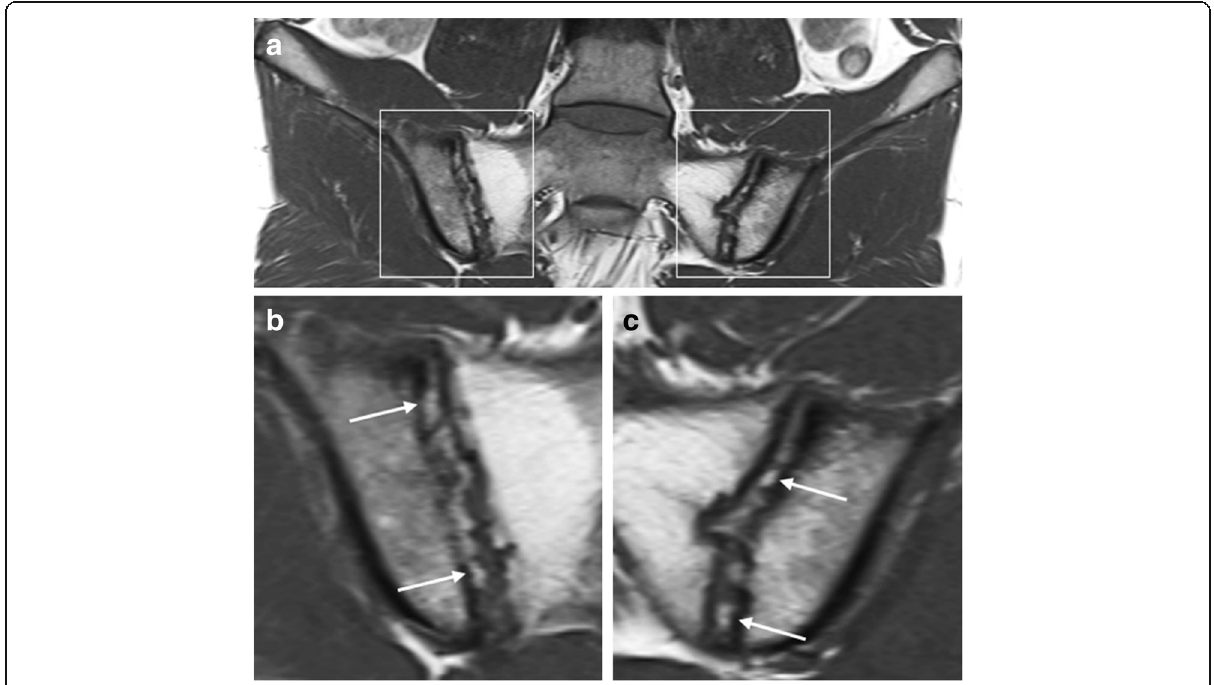
Fig. 2 Intra-articular high signal intensity in the sacroiliac joints space on T1-weighted MR images. Coronal oblique T1-weighted MR images acquired in a 25-year-old man with SpA show high intra-articular signal intensity (arrows). This high signal intensity is clearly filling up the eroded iliac bone on the right (i.e., “ backfill ” ). Extensive fatty degeneration of the bone marrow of the sacral side of the sacroiliac joints is present, i.e., post-inflammatory structural changes. Note: b and c are enlargements of the regions outlined in